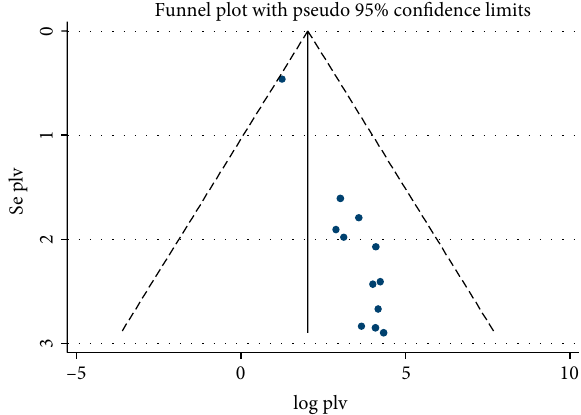
Figure 3: Funnel plot for publication bias, Logprop Or Lnp (Log of Proportion) represented in the X-axis and standard error of log proportion in the